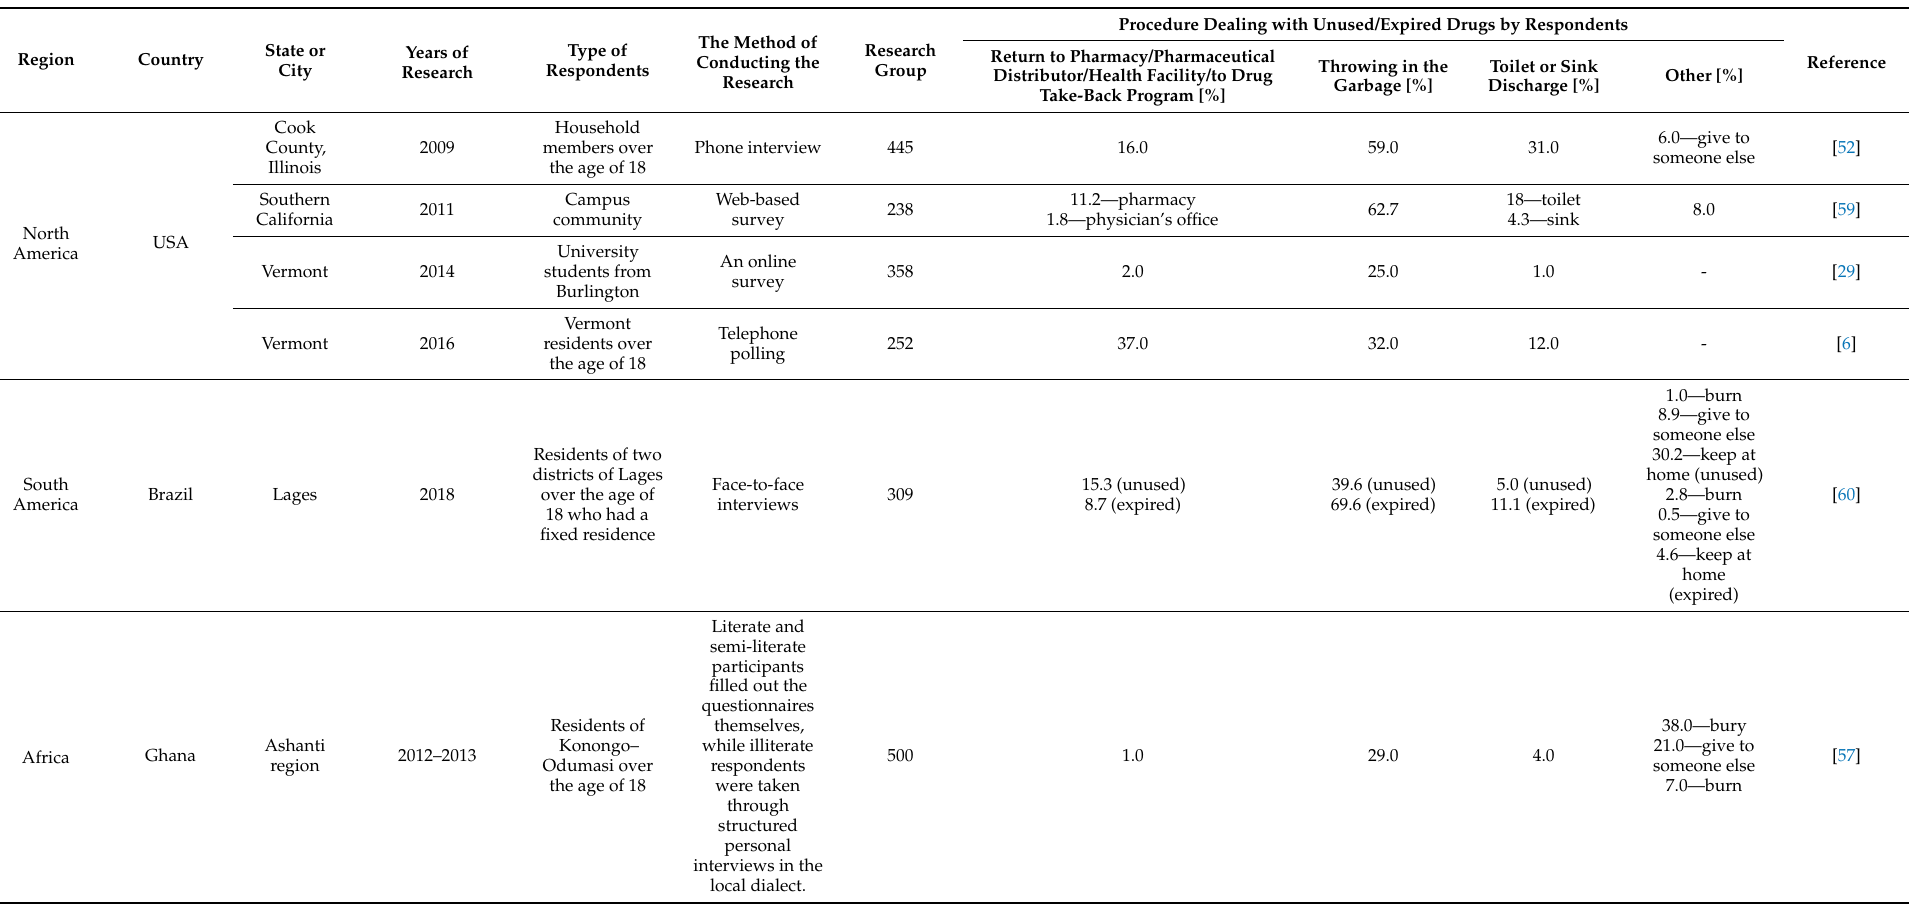
Table 1. The way of dealing with unused/expired medicines by respondents around the